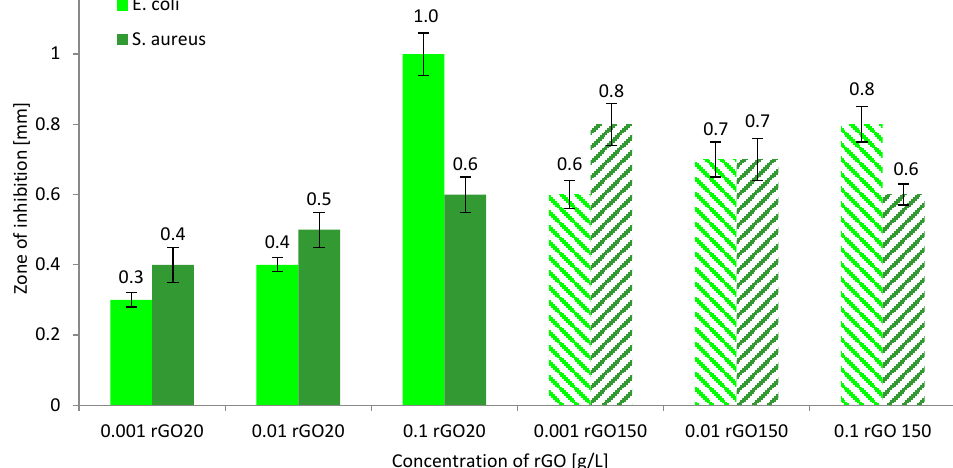
Figure 6. Growth inhibition zones for E. coli and S. aureus bacteria depending on the concentration of reduced graphene oxide (rGO20 and rGO150).